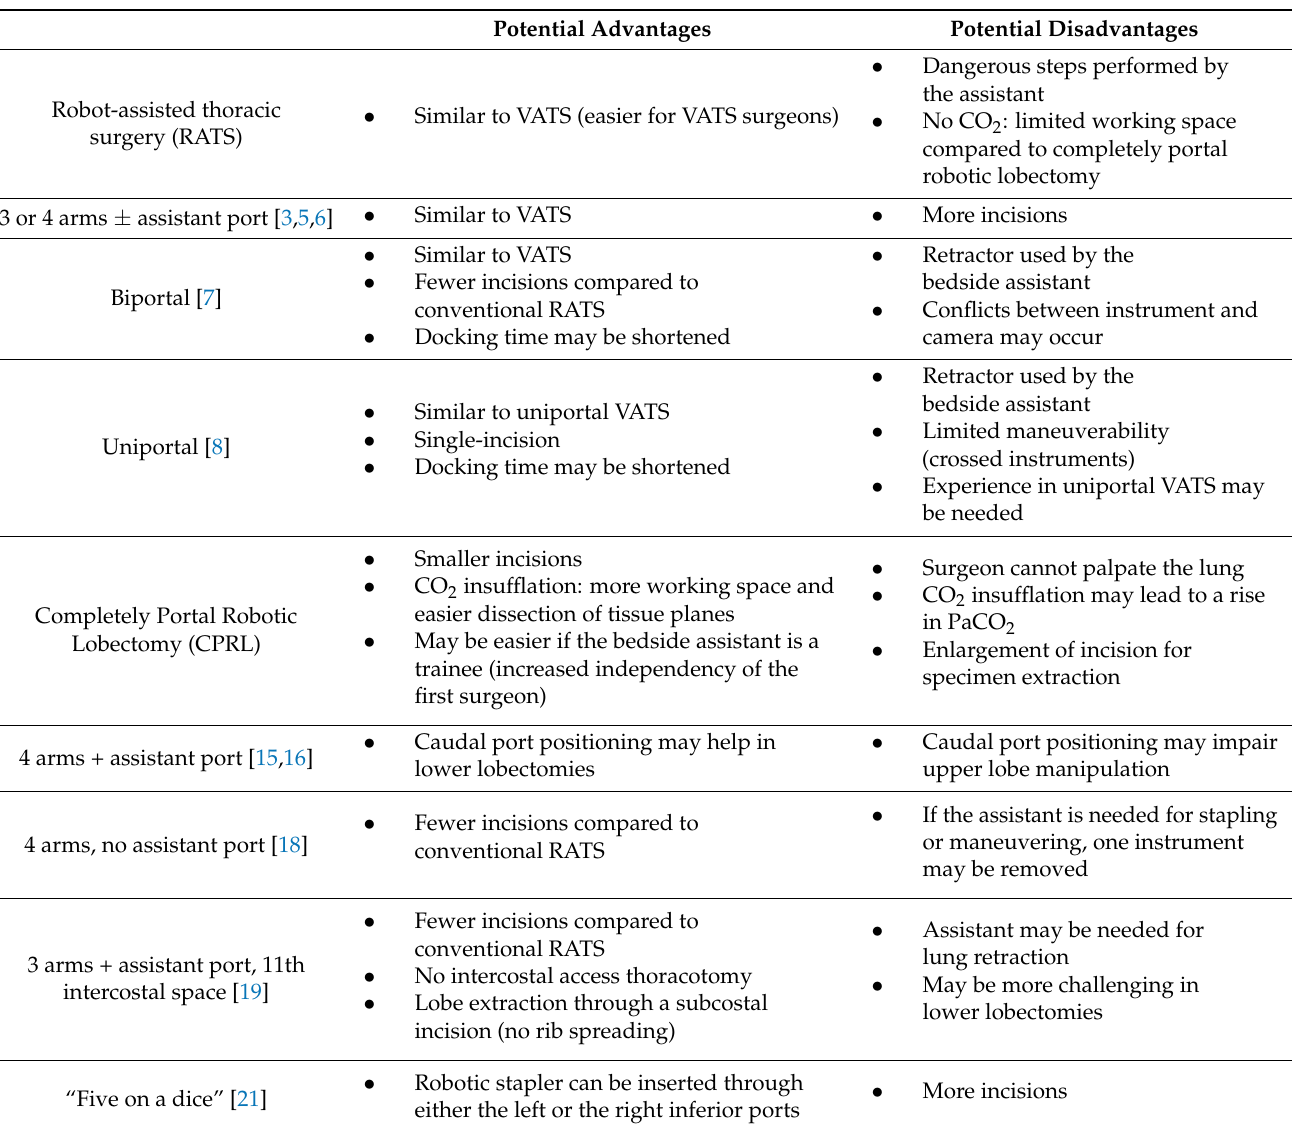
Table 1. Main robotic port strategies and their potential advantages and